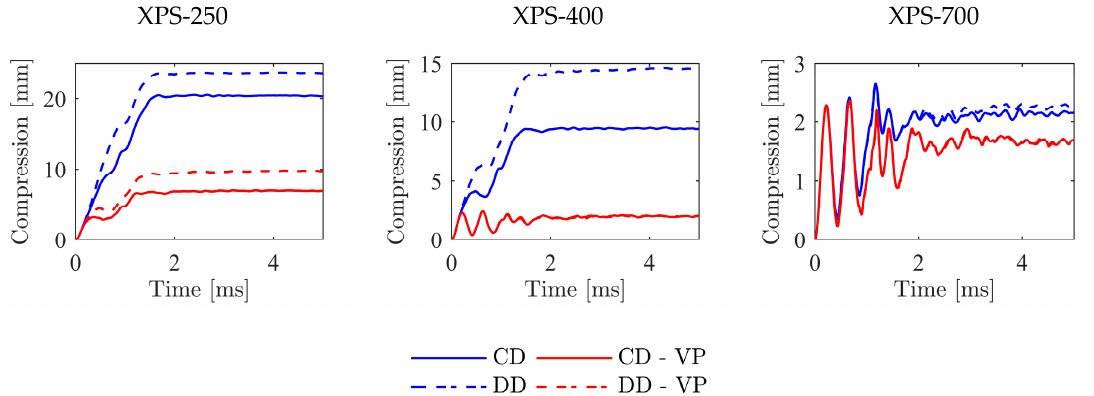
Figure A11. Core compression from simulations of tests at 15 bar firing pressure.